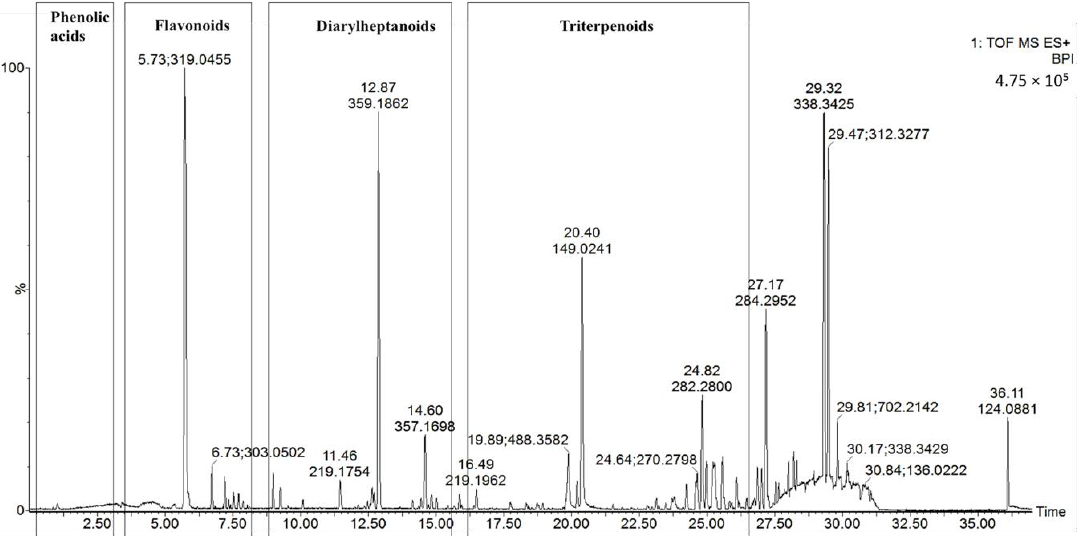
Figure 1. Representative based peak intensity (BPI) chromatograms of the MRB extract in the positive-ion mode. Table 1. Information of the 19 tentative identified compounds from the MRB extract